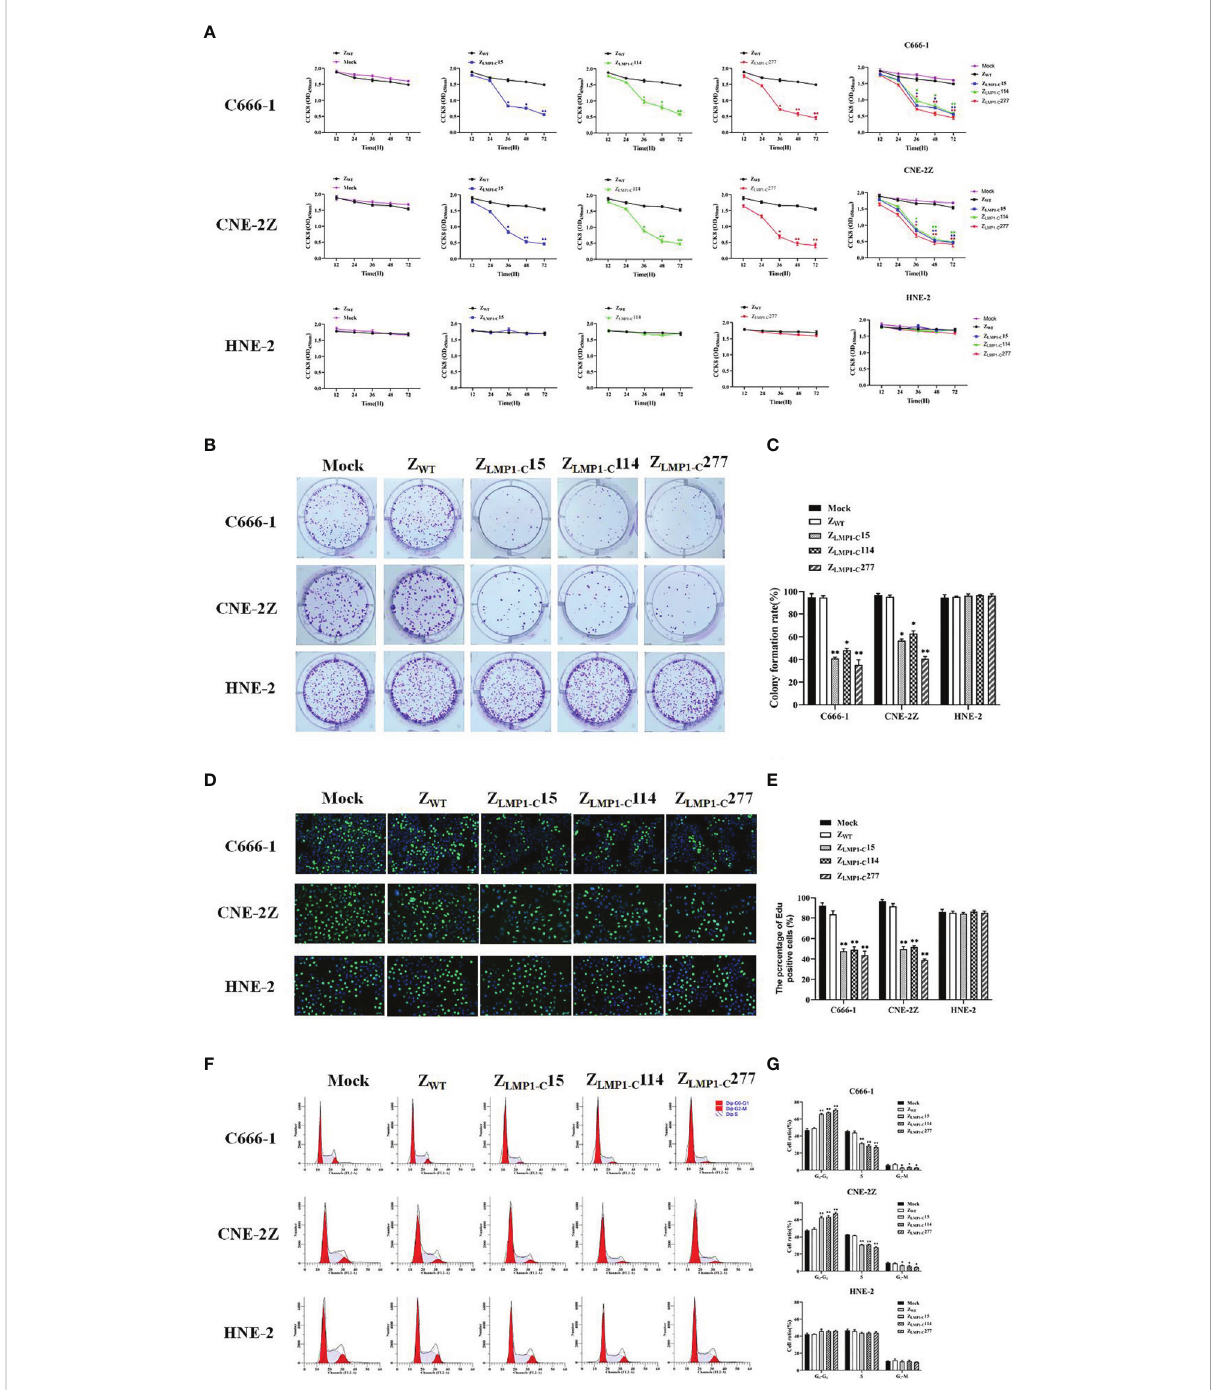
FIGURE 3 Z LMP1-C af fi body molecules signi fi cantly inhibited NPC cells proliferation. CCK-8 assays were performed to determine the effects of Z LMP1-C af fi body molecules on C666-1, CNE-2Z and HNE-2. (A) EBV-positive NPC cell lines incubated with Z LMP1-C af fi body molecules reduced the cell viability compared with Z WT control, whereas EBV-negative NPC cell line incubated with Z LMP1-C af fi body molecules had no effects on cell viability. (B) Colony formation assays were performed for 14 days. The medium and Z WT were set as control groups. (C) The graph showed the percentage of colony-forming units after treatment with Z LMP1-C af fi body molecules. *P <0.05, **P < 0.01 compared with control. (D) C666-1, CNE-2Z and HNE-2 cells were treated with Z LMP1-C af fi body molecules for 24 h. Cell proliferation was determined by Edu staining. The images shown. Scale bar = 20 m M. (E) Shown are mean values ( ± SD) obtained from three independent repeats. *P <0.05, **P < 0.01. (F) Cell cycle analysis with fl ow cytometry and propidium iodide. (G) Cell percentages in G0/G1, S and G2/M phases were calculated from three independents experiments. *P <0.05, **P <